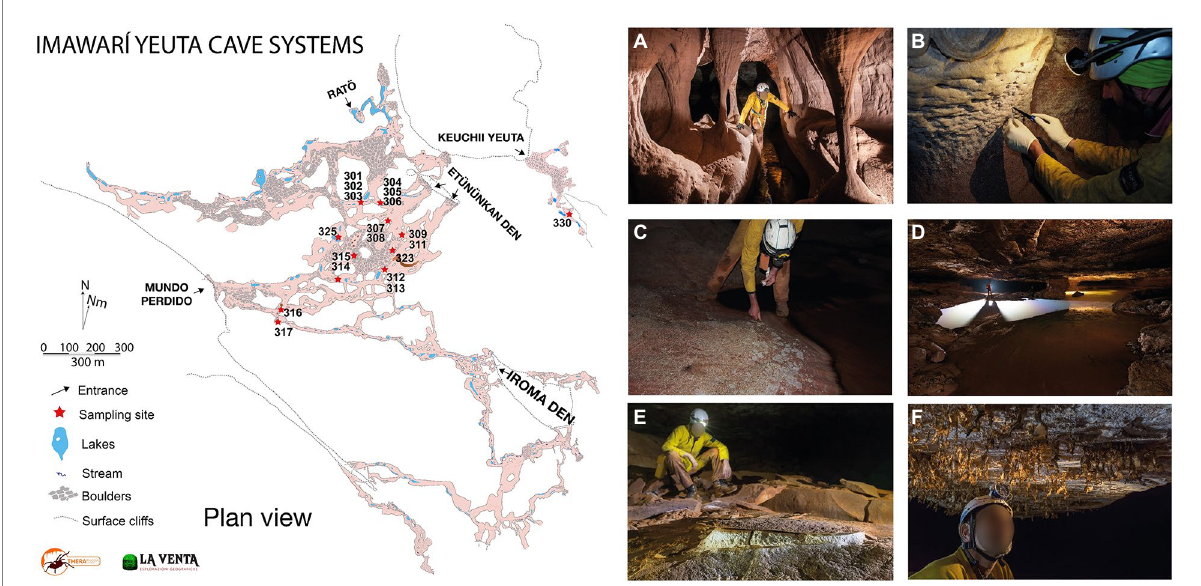
FIGURE 1 Map of Imawarì Yeuta cave and collection sites and examples of different geochemical, morphological, and hydrological environments in the cave. (A) Orthoquartzite columns and eroded walls are typical of hydrologically active branches of the cave, as those where sample Ay317 has been collected (photo La Venta-Alessio Romeo). (B) Cave walls undergoing quartz amorphization are usually covered by a wet paste of Opal-A, as in the sample location of Ay301 and Ay302 (photo La Venta-Francesco Lo Mastro). (C) Polished cave floors on a side of a stream are covered by whitish patches of biological material, as for Ay305 (photo La Venta-Francesco Lo Mastro). (D) Ponds of water covered by iridescent patinas and floating biological material, as for samples Ay303 and Ay314 (photo La Venta-Robbie Shone). (E) Deposits of powdery dry sulfates on the cave floors as for Ay308 and Ay315 (photo La Venta-Riccardo de Luca). (F) Fragile molds of silica resembling spider webs hanging from cave roofs, as for sample Ay323 (photo La Venta-Riccardo de